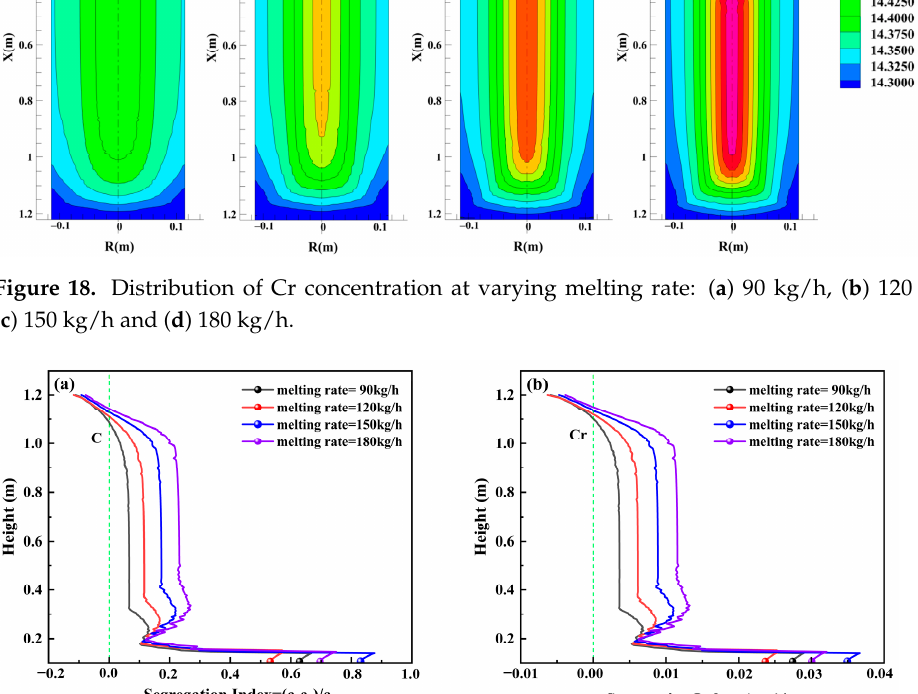
Figure 19. Change of C ( a ) and Cr ( b ) centerline segregation index at varying melting rate.